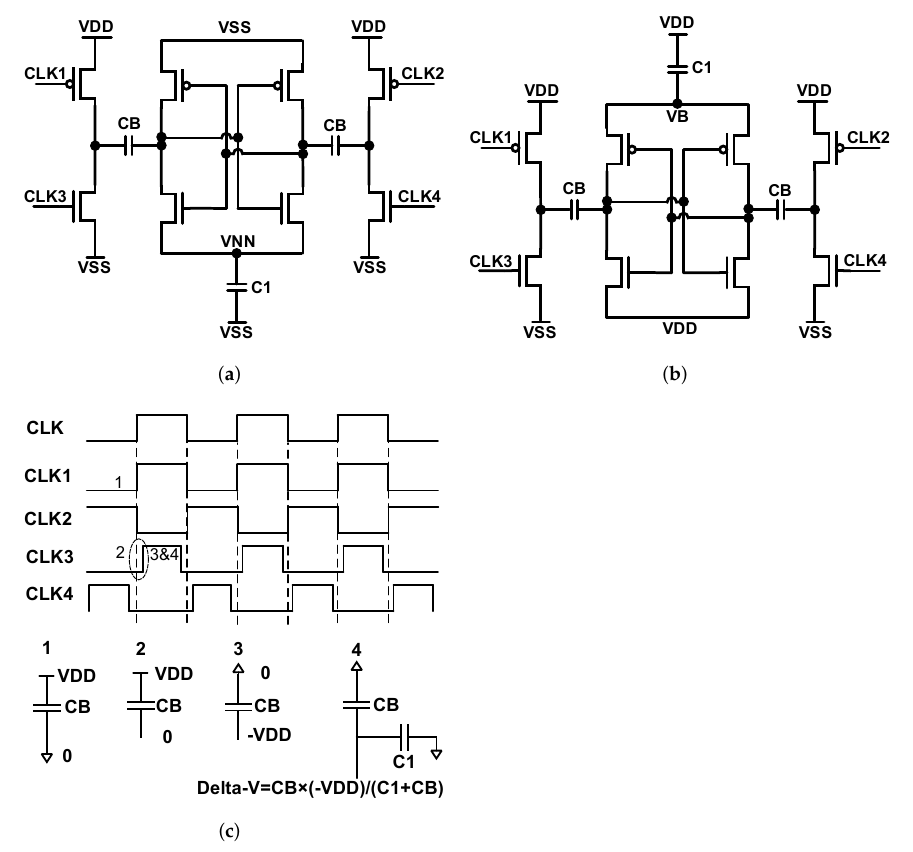
Figure 13. ( a ) Negative charge pump, ( b ) voltage booster and ( c ) process of charging and storing on storing